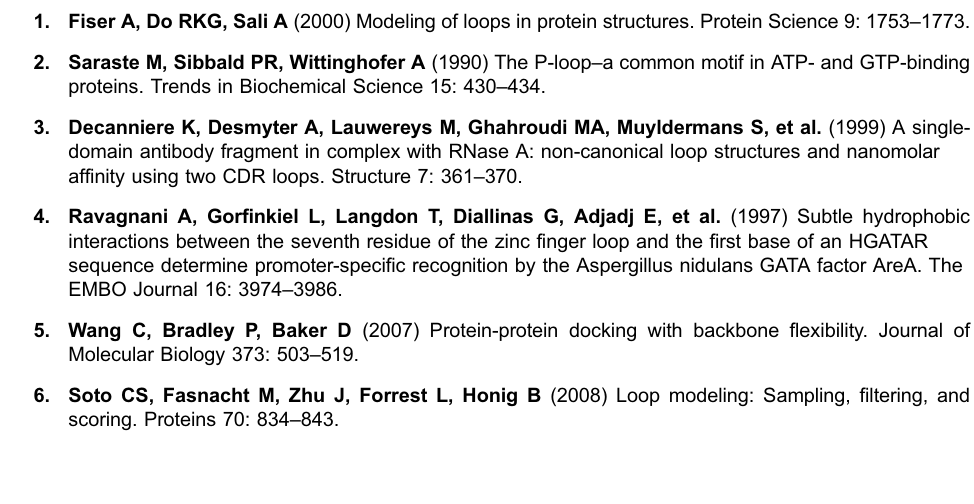
Table S5. Loop modeling results on the perturbed crystal structures for the 12- residue loop Set 1. Table S6. RMSD results of the modeled loops for template-based models. Table S7. Loop reconstruction results and modeling results on perturbed crystal structures for the 12-residue loop Set 1 using energy functions composed of either knowledge-based or physics-based energy components. Table S8. Loop modeling results for the 12-residue loop Set 1 in three different environments with a smaller number of CSA bank size ( N 5 30 instead of N 5 50). Table S9. Contribution of each energy component. Table S10. Correlation between energy and decoy loop RMSD calculated using different subsets of energy